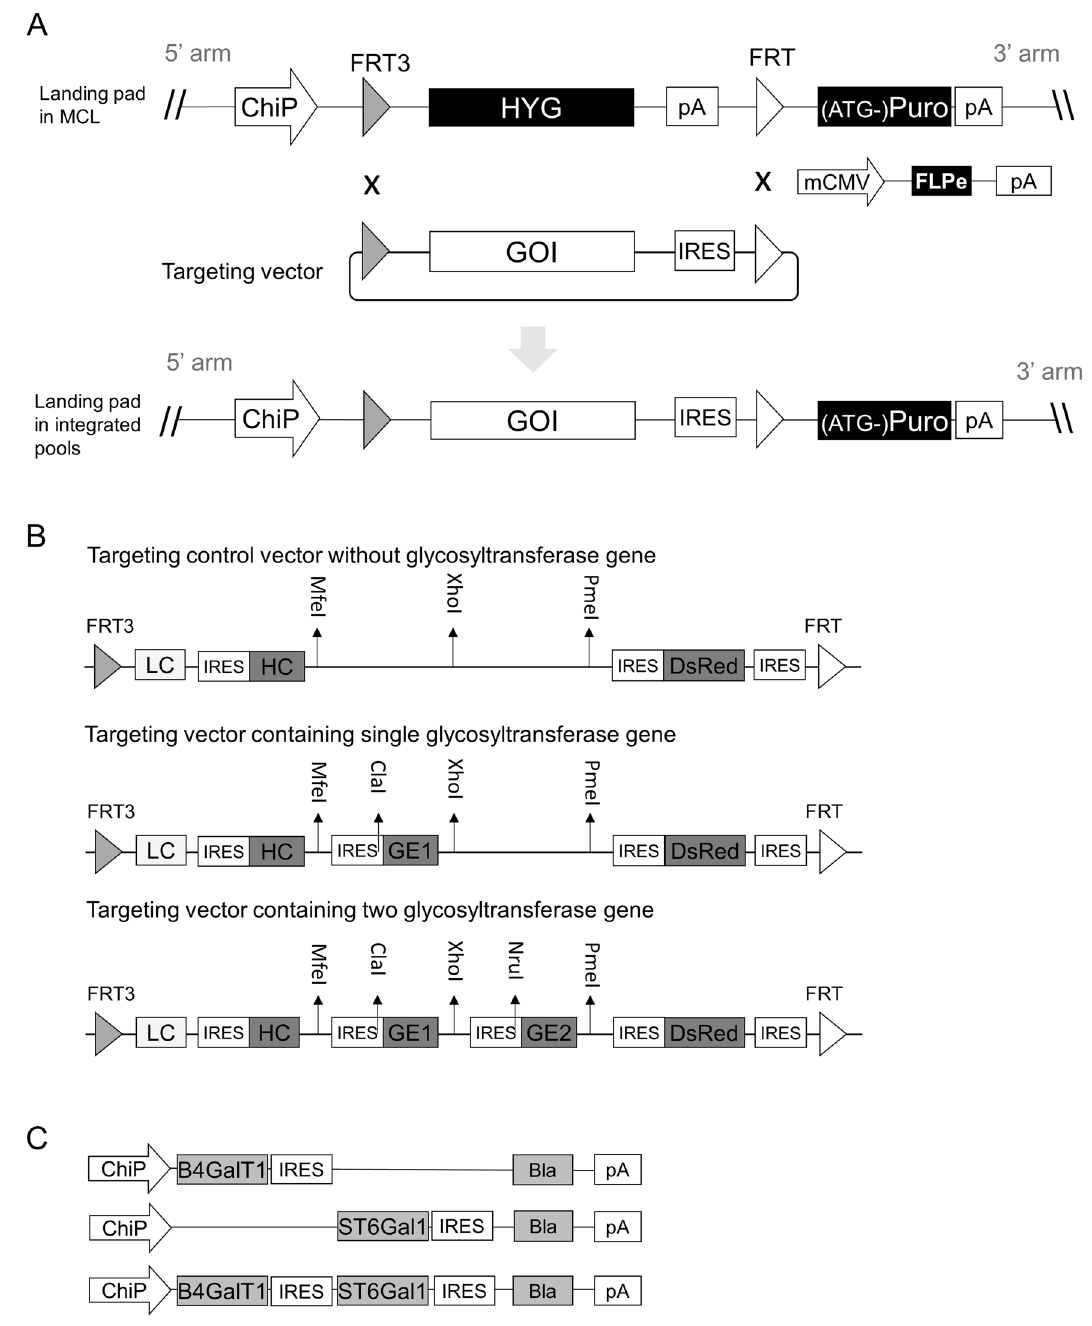
Figure 1. Overview of RMCE and plasmid vectors for the generation of stably transfected CHO cell pools that co-express IgG and human glycosyltransferase genes. ( A ) Schematic representation of RMCE. ( B ) Schematic representation of targeting plasmid vectors carrying IgG rituximab LC and HC genes together with one or two human glycosyltransferase genes and DsRed gene. ( C ) Schematic representation of plasmid vectors expressing B4GalT1 and ST6Gal1 individually or in combination for random integration. RMCE, recombinase-mediated- cassette-exchange; MCL, master cell line; GOI, gene of interest; ChiP, a chimeric promoter consisting of murine cytomegalovirus (CMV) enhancer, human CMV core promoter and human CMV intron A; mCMV, murine CMV enhancer and promoter; FRT and FRT3, wild-type and mutated flippase recognition targets; Flpe, enhanced recombinase flippase; IRES, wild-type encephalomyocarditis virus (EMCV) internal ribosome entry site (IRES); pA, simian virus 40 polyadenylation signal; LC, light chain cDNA; HC, heavy chain cDNA; G.E.1, glycosyltransferase gene 1; G.E.2, glycosyltransferase gene 2; DsRed, cDNA encoding red fluorescent protein; (ATG-)Puro, start-codon ATG-deleted puromycin resistence gene; Bla, blasticidin-S resistance gene; B4GalT1, β-1,4-Galactosyltransferase 1 gene; ST6Gal1, β-Galactoside -α-2,6-sialyltransferase 1